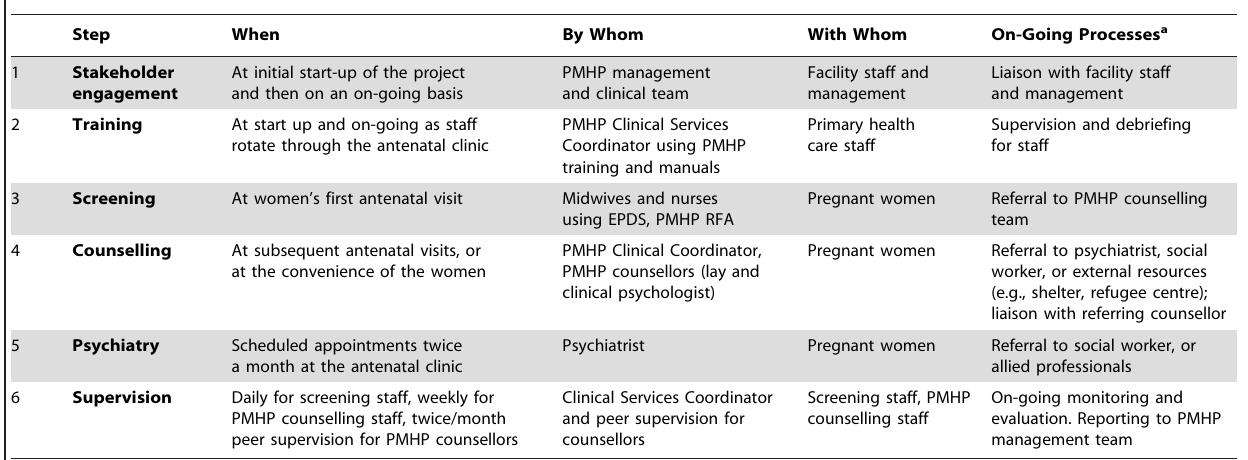
Table 1. PMHP stepped care model and organogram.